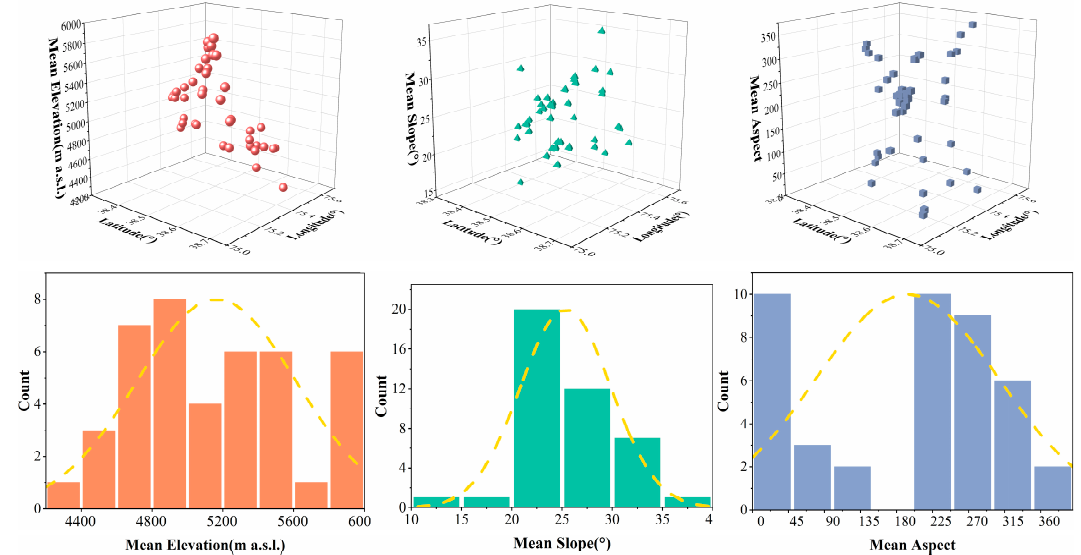
Figure 13. Three-dimensional distribution of elevation, slopes, and aspect of the glaciers.